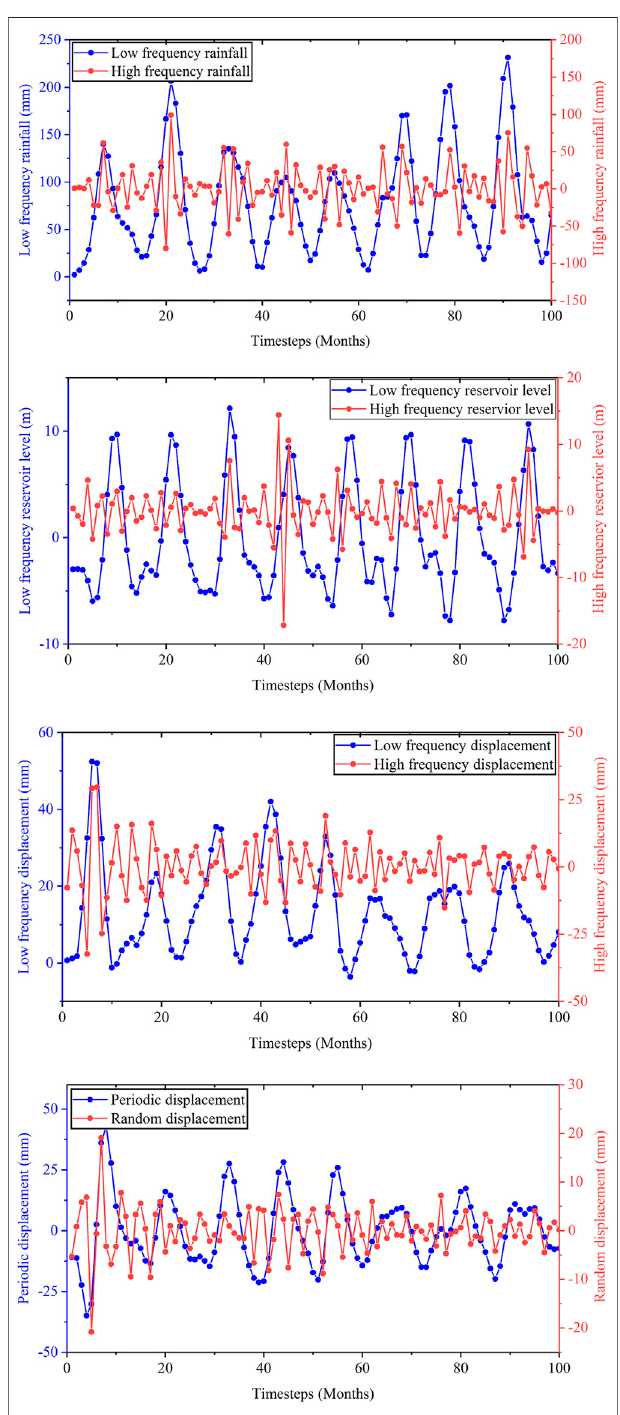
FIGURE 5 | Plots exhibiting the decomposition of different in fl uencing factors.